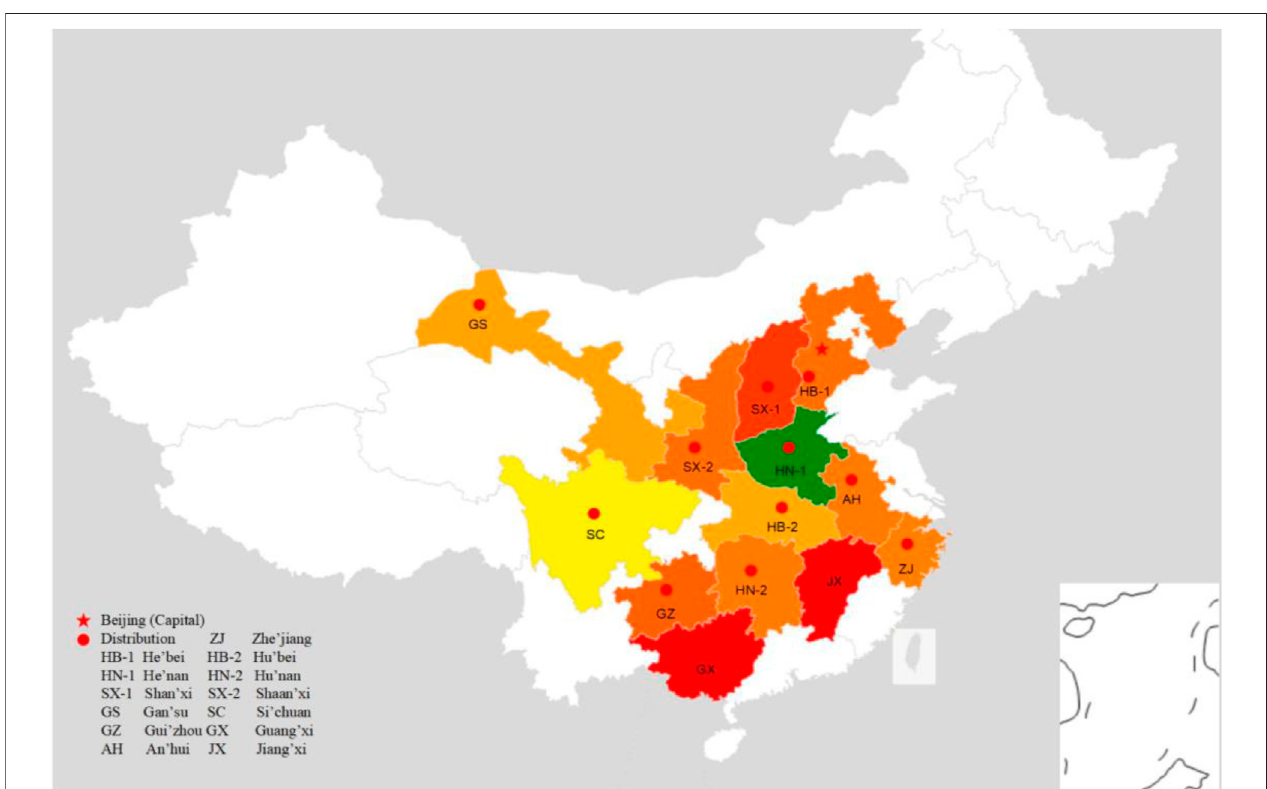
FIGURE 2 | The red spots in the map depicted the main region of I. rubescens distribution in